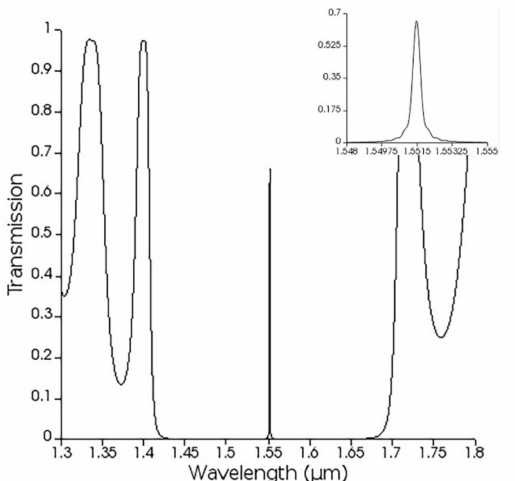
Figure 4. The simulated transmission result of a single 1D PhC.